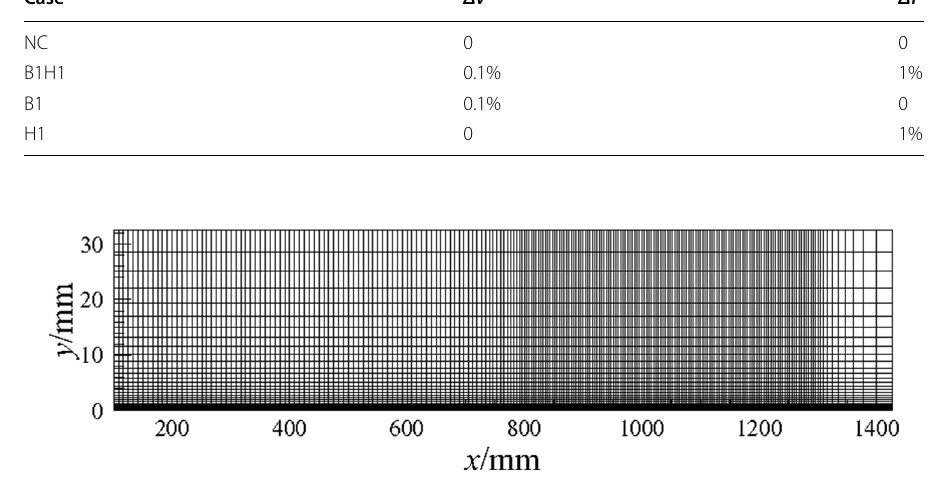
Fig. 2 Schematic of computational mesh